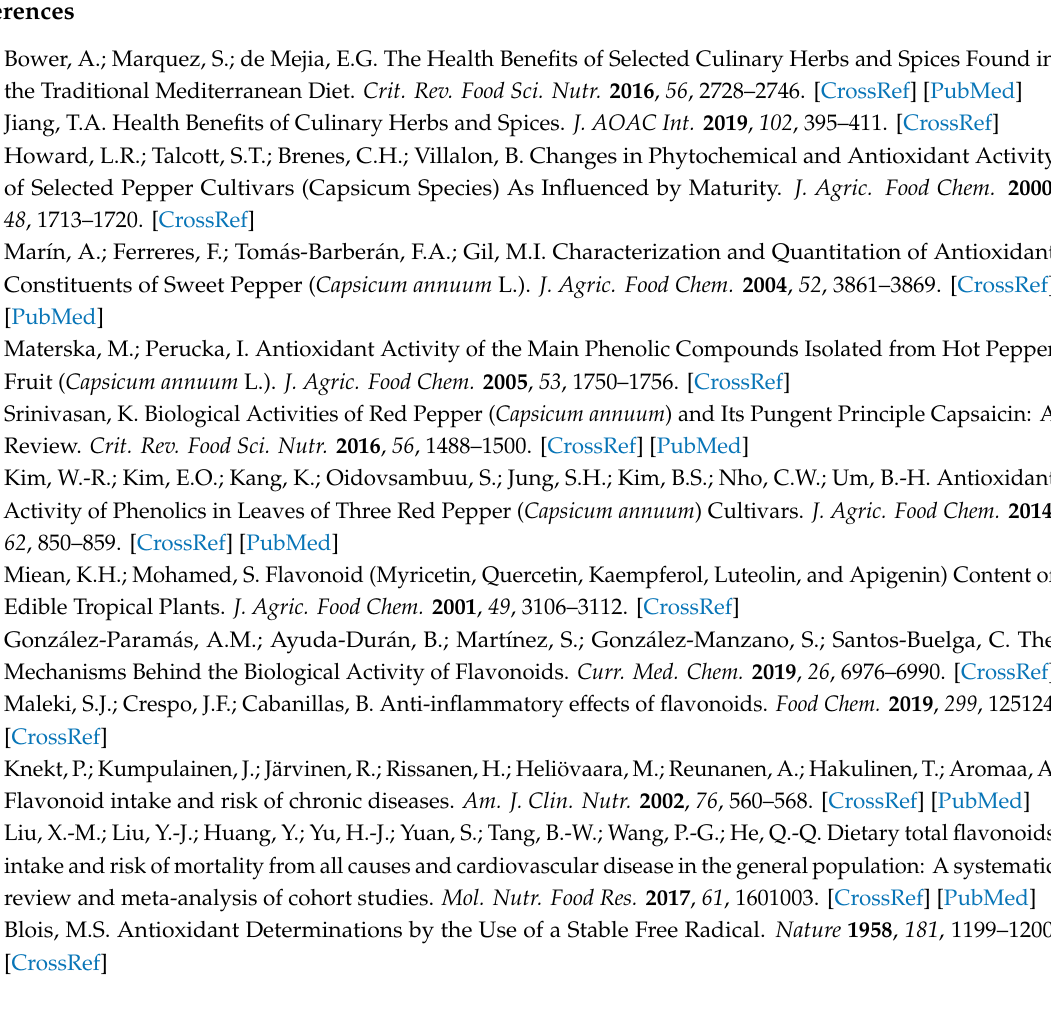
Figure S1: The cytotoxicity of pepper leaf (PL) and pepper fruit (PF) extracts on RAW 264.7 macrophages was measured by MTS